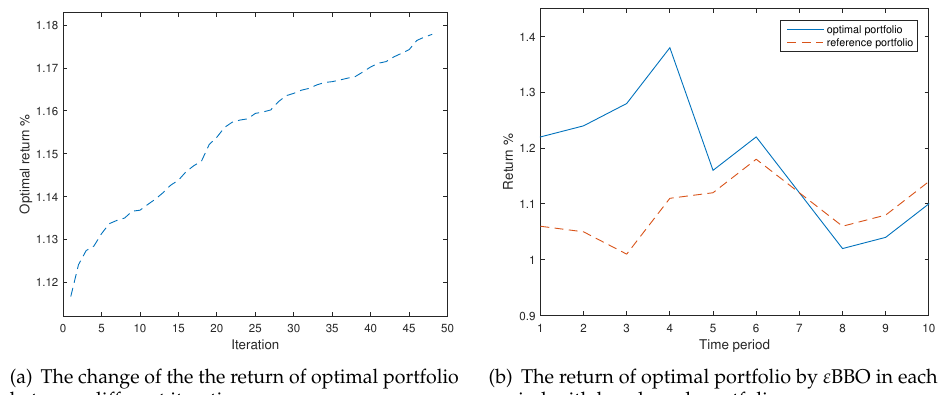
Figure 5. The performance of the ε BBO and the optimal portfolio in X ∈ [ 0,0.6 ] of model (29).